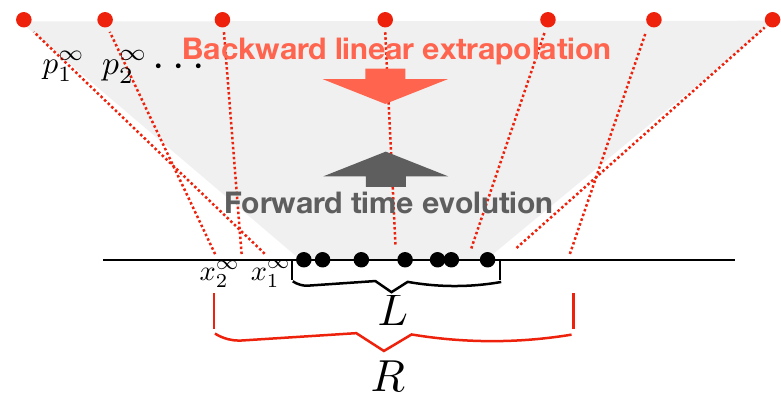
Figure 5: The scattering map. The physical particles (black dots) lie on an interval of length L . After a long-time evolution (shaded gray region), they are far apart (red dots). Their velocities p ∞ , and the impact parameters x ∞ – the intercept of n n the zero-time slice with the asymptotic trajectories’ extrapolations (red dotted line) – characterise the asymptotic configuration. The impact parameters lie on an interval of length R , generically different from L